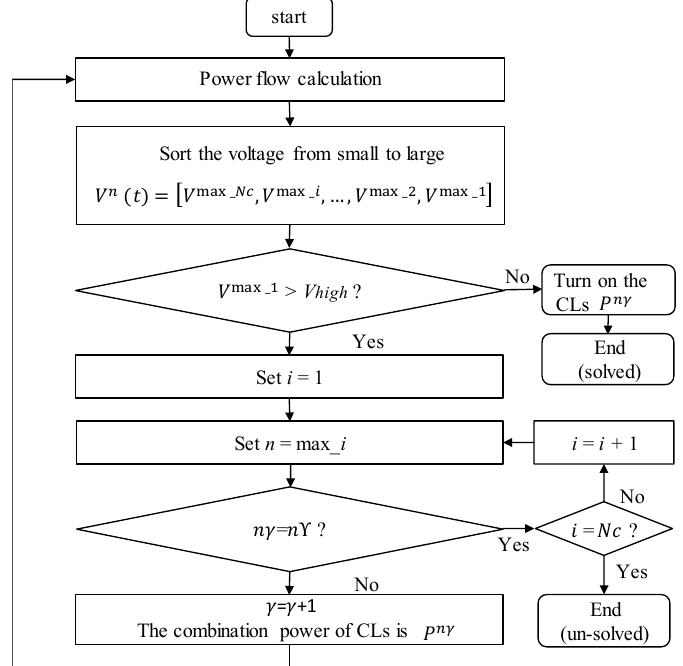
Figure 6. Flow chart of the voltage ranking search algorithm (VRSA): over-voltage regulation.